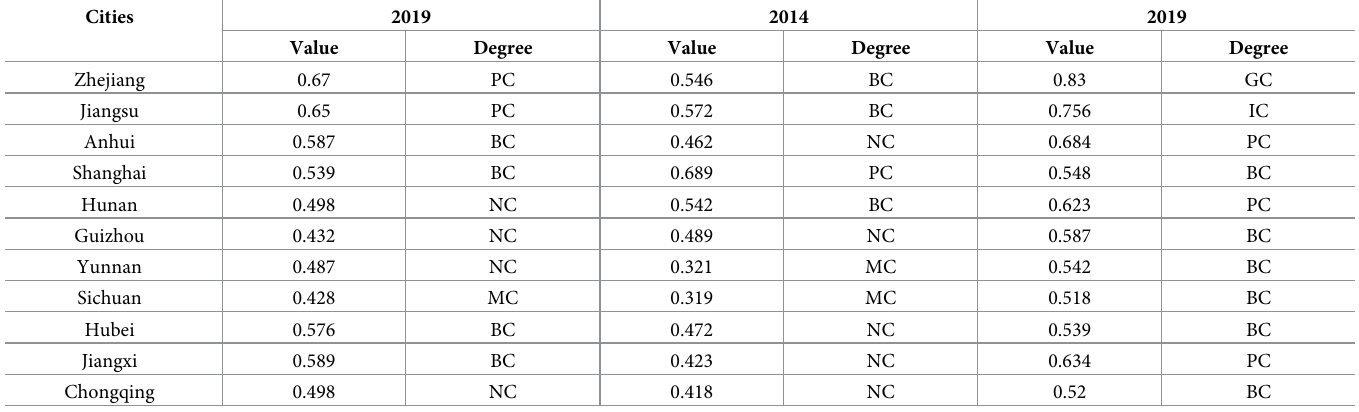
Table 5. Spatial coordination analysis of logistics and